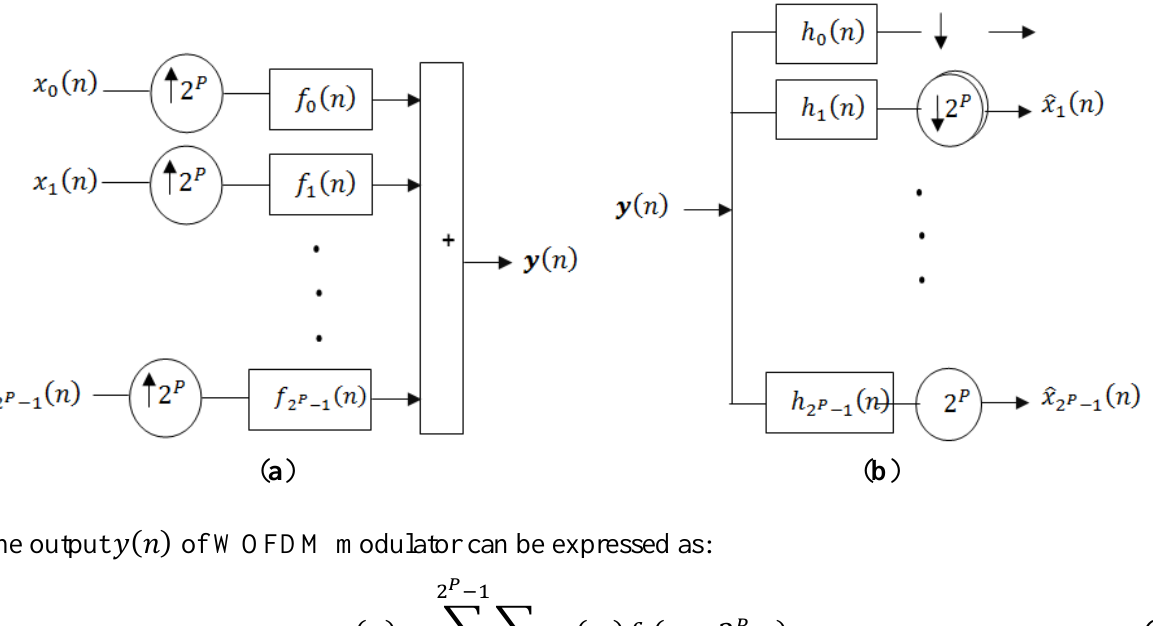
Figure 2. Equivalent structure of WOFDM modulator and demodulator using noble identities. ( a ) A sub-channel WOFDM modulator; ( b ) A sub-channel WOFDM